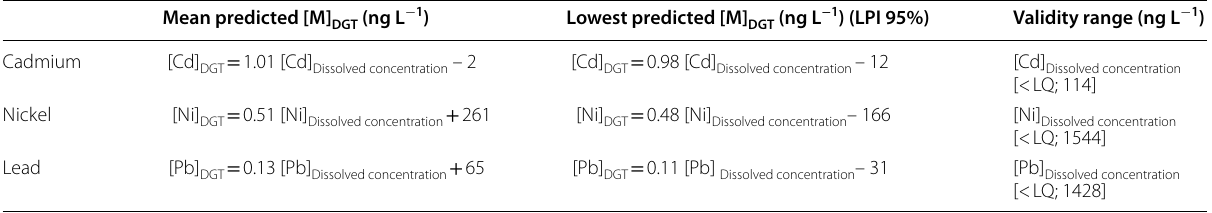
Table 2 Application of Eq. (1) for predicting Cd, Ni and Pb DGT labile concentrations from dissolved concentrations